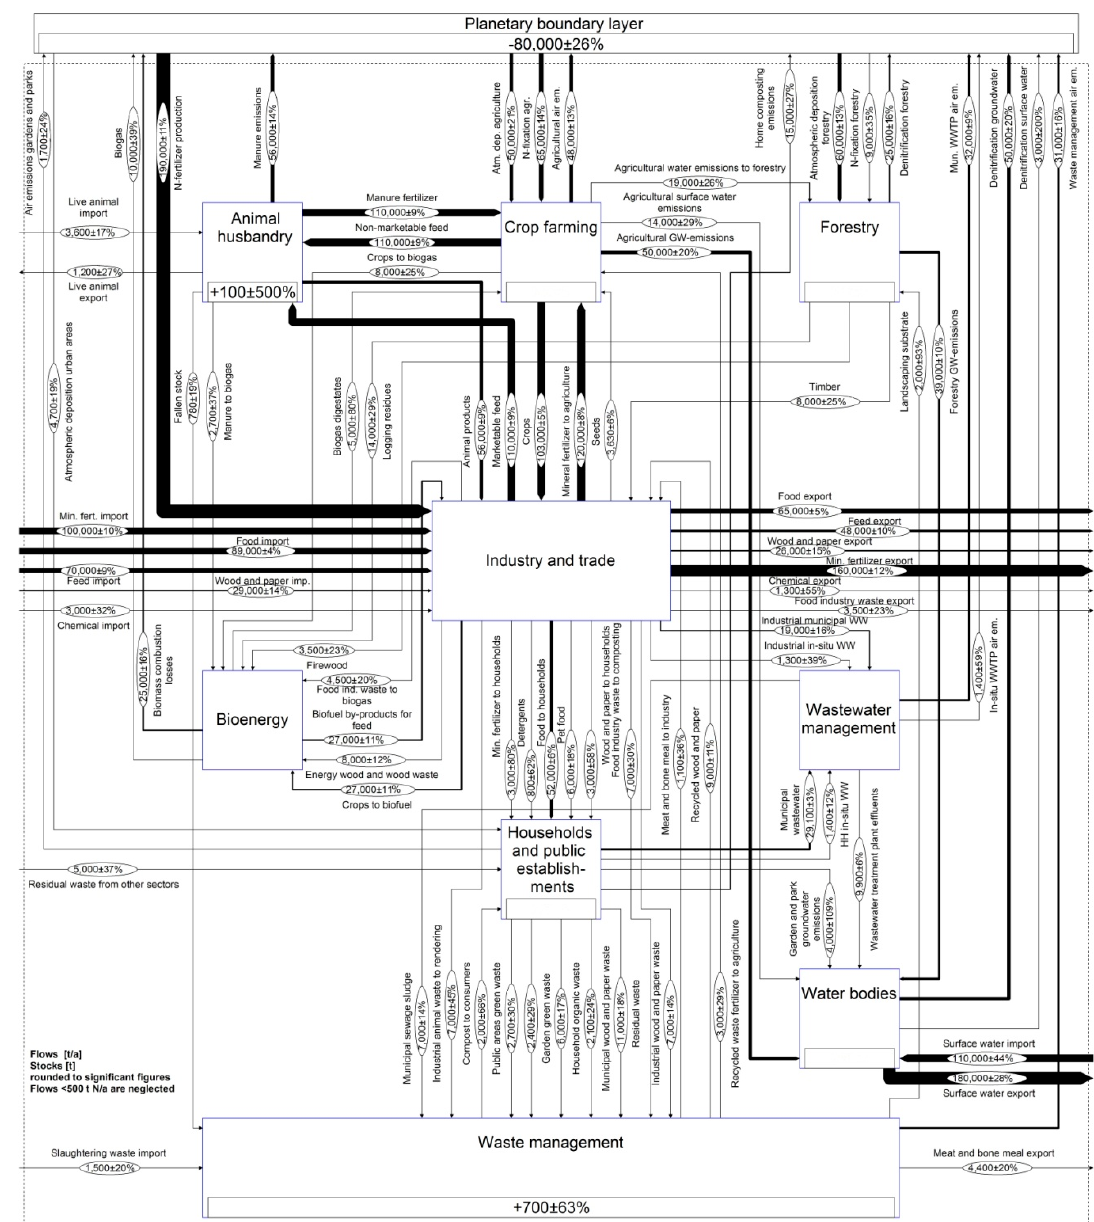
Figure 2. The Austrian N system 2015.